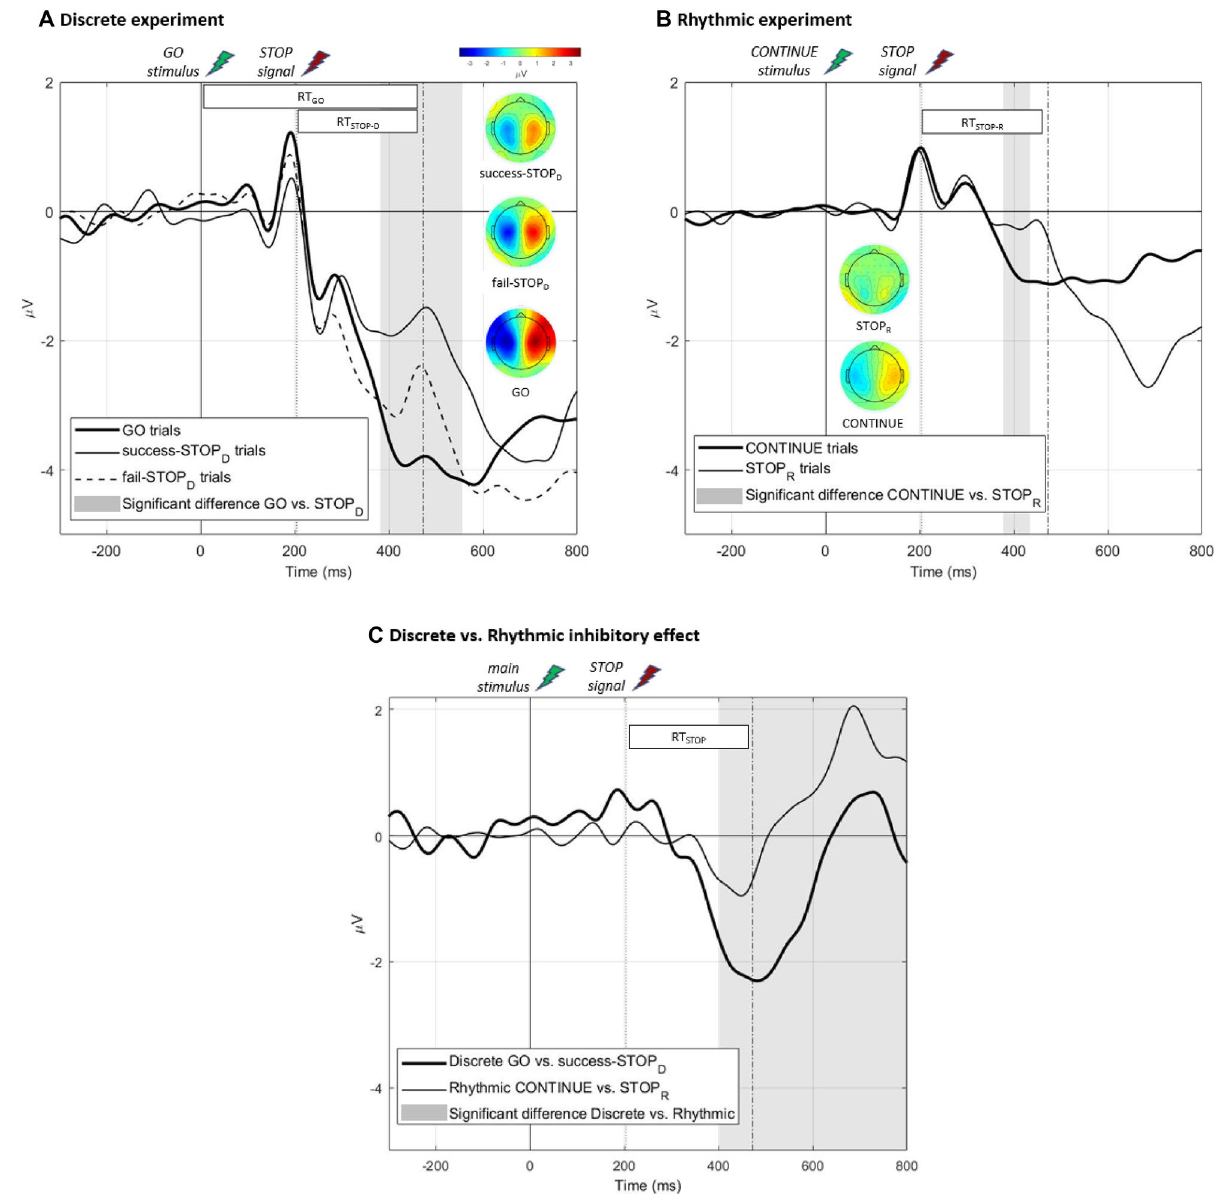
Figure 1. LRP analysis Panel ( A ): LRP (grand–average) computed in the discrete GO D , success-STOP D , and fail-STOP D conditions. GO D LRP differed significantly from success-STOP D and fail-STOP D conditions. In grey, the region of significant difference (according to the nonparametric permutation analysis) between GO D and success-STOP D conditions ( P < .05, corrected). Panel ( B ): LRP (grand–average) computed in the rhythmic CONTINUE and STOP R conditions. In grey, the region of significant difference between the two conditions ( P < .05, corrected). Topographies are presented in panels ( A ) and ( B ) as the lateralized topographies computed at each condition LRP peak latency (see “Method” section). Panel ( C ): LRP inhibitory effect computed in the discrete (GO D minus success-STOP D LRP) and the rhythmic (CONTINUE minus STOP R LRP) experiments. In grey, the region of significant difference between these two differential LRPs ( P < .05, corrected). The represented SSD, RT GO and RT STOP latencies are based on the average of the obtained latencies over all the participants. LRPs were 15 Hz low-pass filtered for graphical To detect significant ERD and ERS, the resulting Mu and Beta power time series of each condition was com- pared against the mean value of the power in the baseline time range (− 400 to − 100 ms). These comparisons were performed based on a non-parametric permutation procedure (see below). Thus, each time-period for which the power values were significantly below the baseline level was indexed as an ERD. Each time-period subsequent to an ERD and for which power did not significantly differ from the baseline level was indexed as an ERS. Each time-period including power values that were significantly above the baseline level was indexed